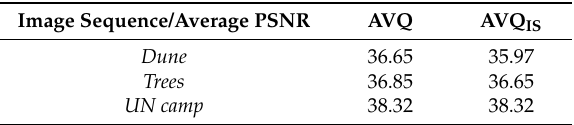
Table 8. Average PSNR (dictionary composed by 8192 entries)–Dataset 2.